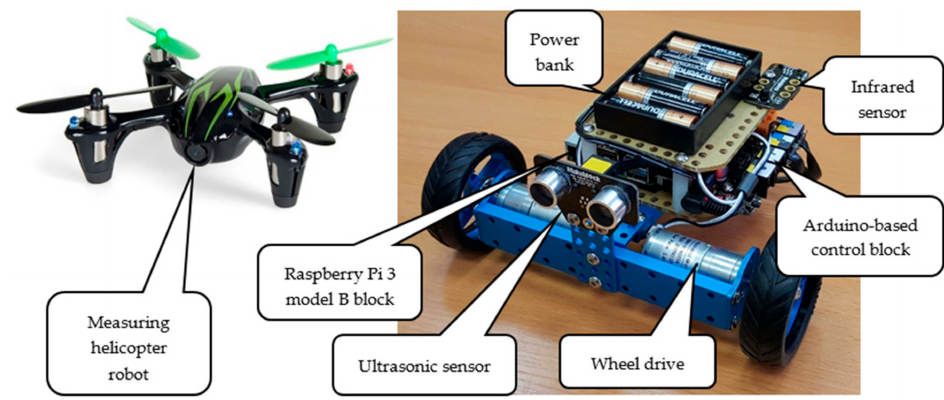
Figure 7. The measuring robot